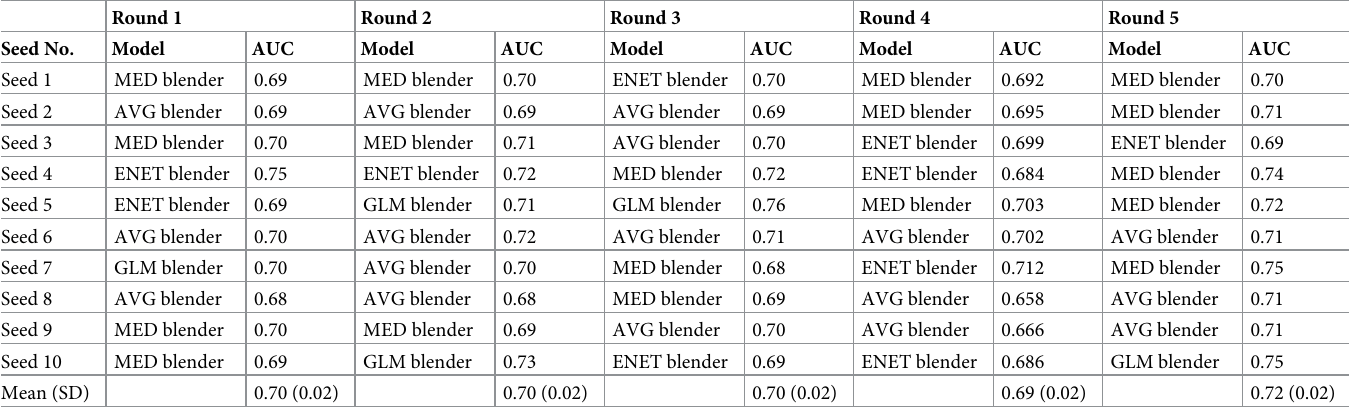
Table 2. Model accuracy of each round and random